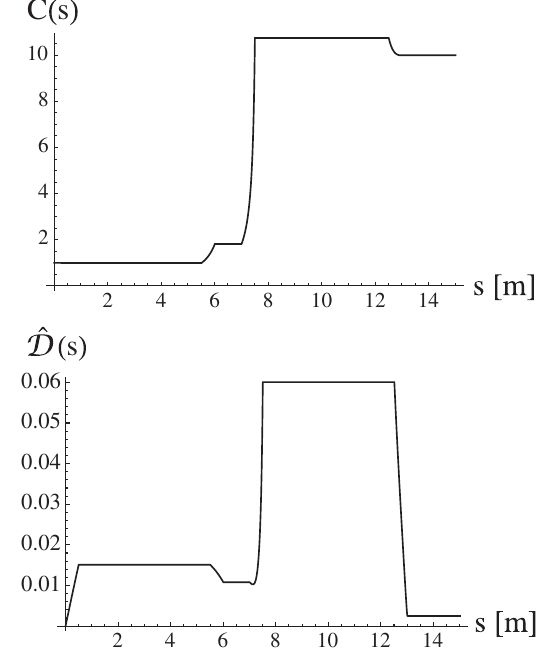
FIG. 7. (Upper) The compression factor C as a function of path length through the lattice shown in Fig. 6. (Lower) The factor of (38) as a function of path length through the lattice shown in Fig.